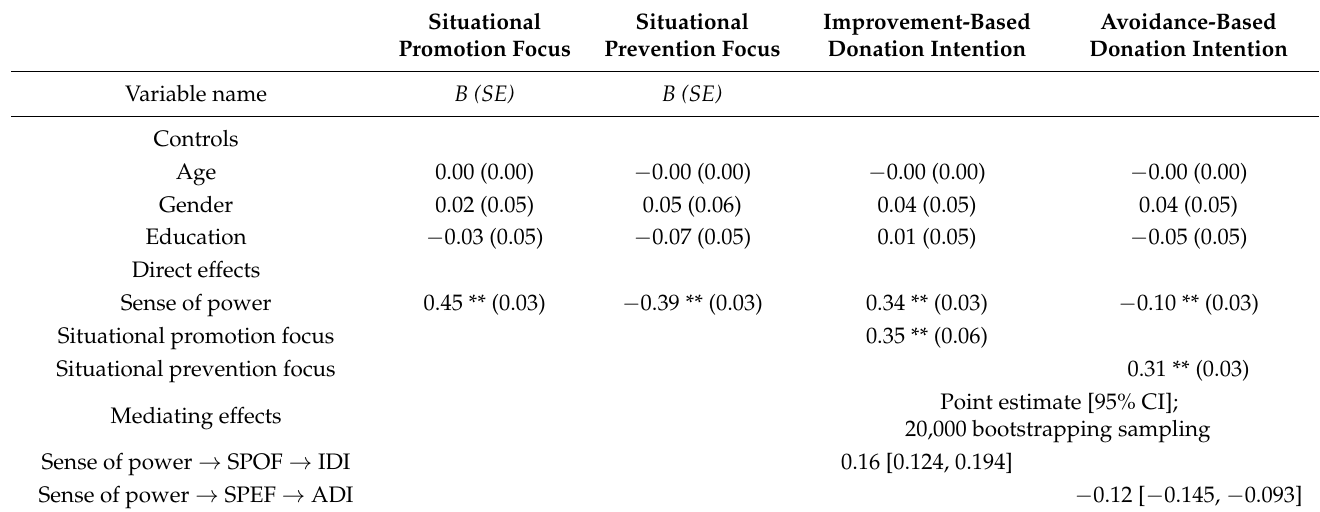
Table 2. Direct and indirect effects of sense of power on improvement-based donation intention and avoidance-based donation